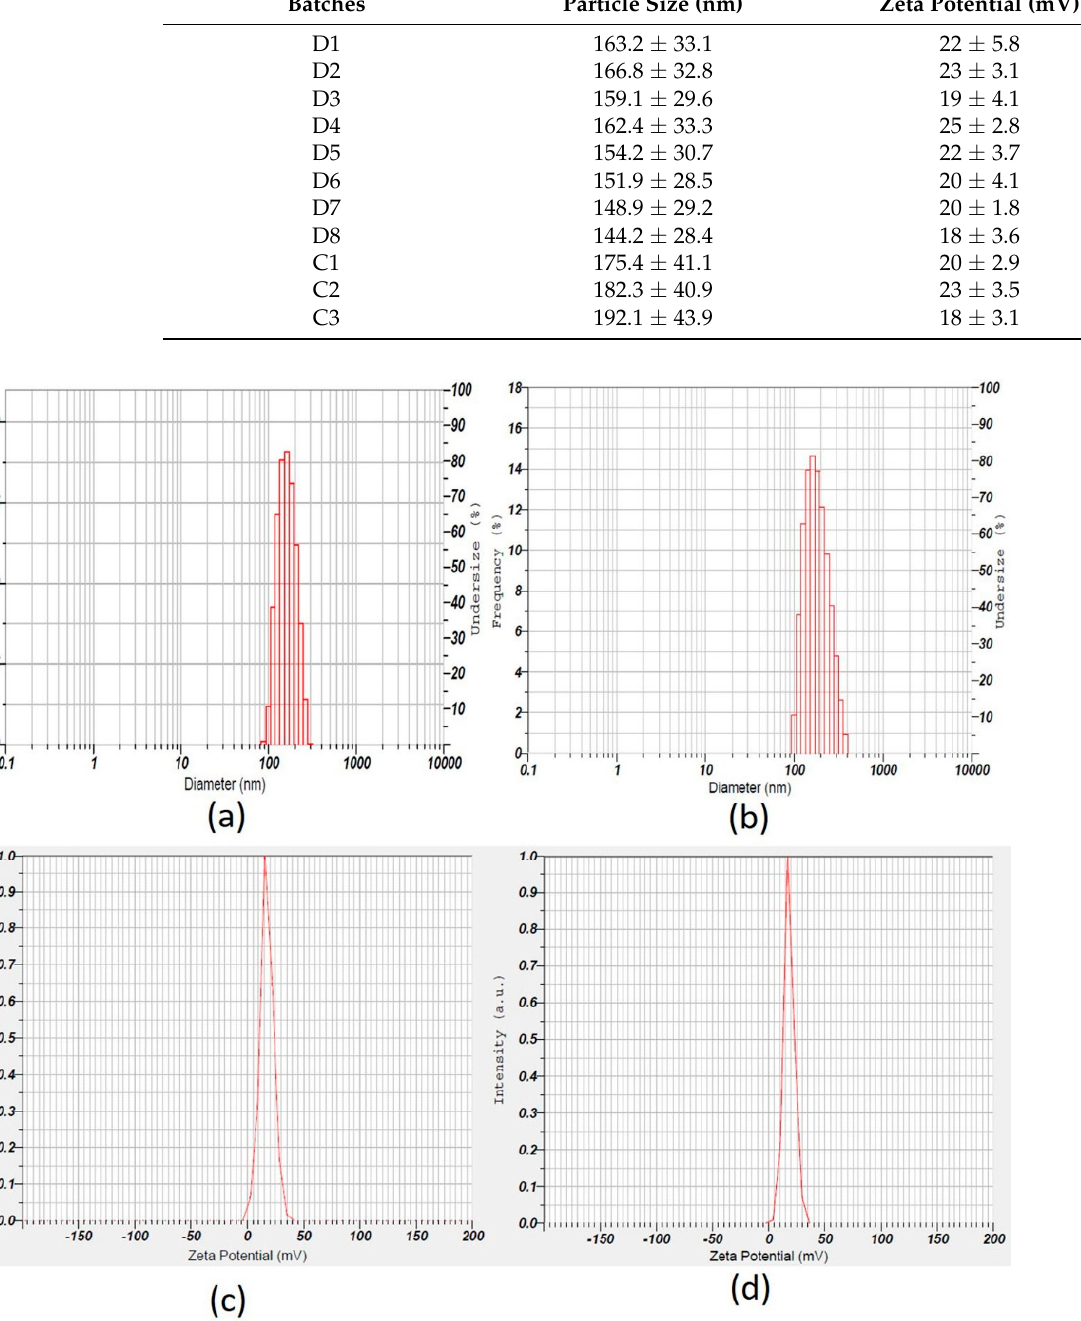
Figure 7. Upper panel: Representative size distribution curve of ( a ) uncoated (batch D8), ( b ) coated nanoparticles (batch C1). Lower panel: Representative zeta potential distribution pictures of ( c ) uncoated (batch D8), ( d ) coated nanoparticles (batch C1).